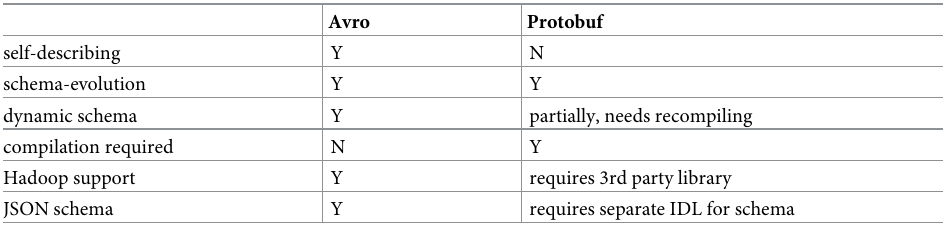
Table 1. A comparison of Avro versus Protobuf for managing biomedical